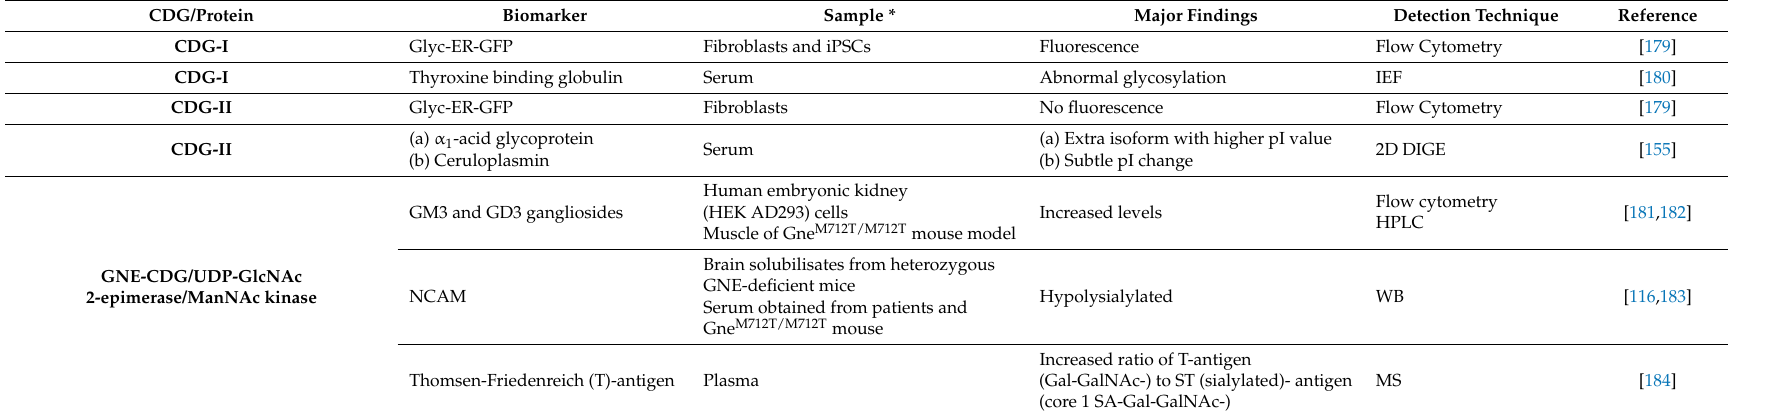
Table 3. Overview of other biomarkers reported for